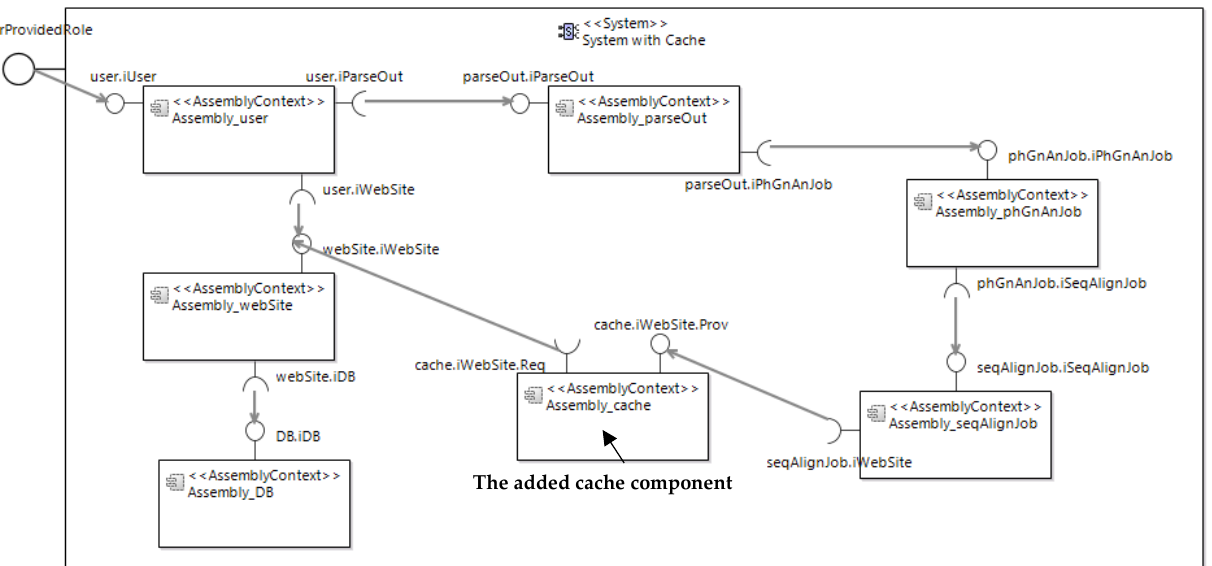
Figure 9. Cache component added to the repository diagram of the system.